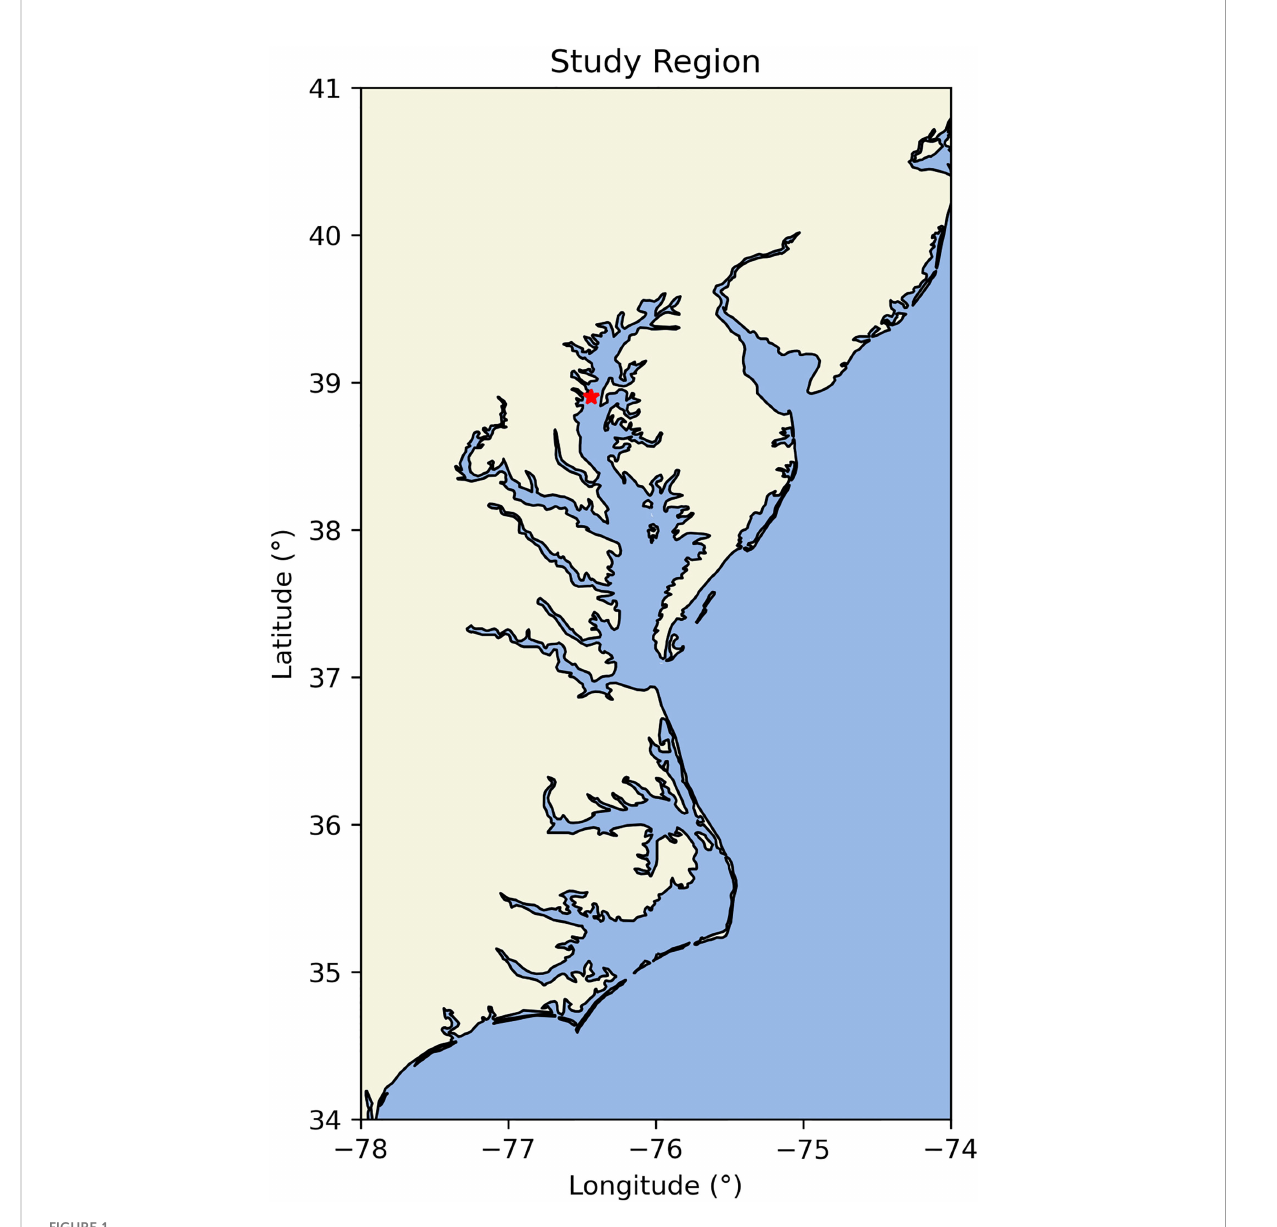
FIGURE 1 Location of the Thomas Point station (red star) within Chesapeake